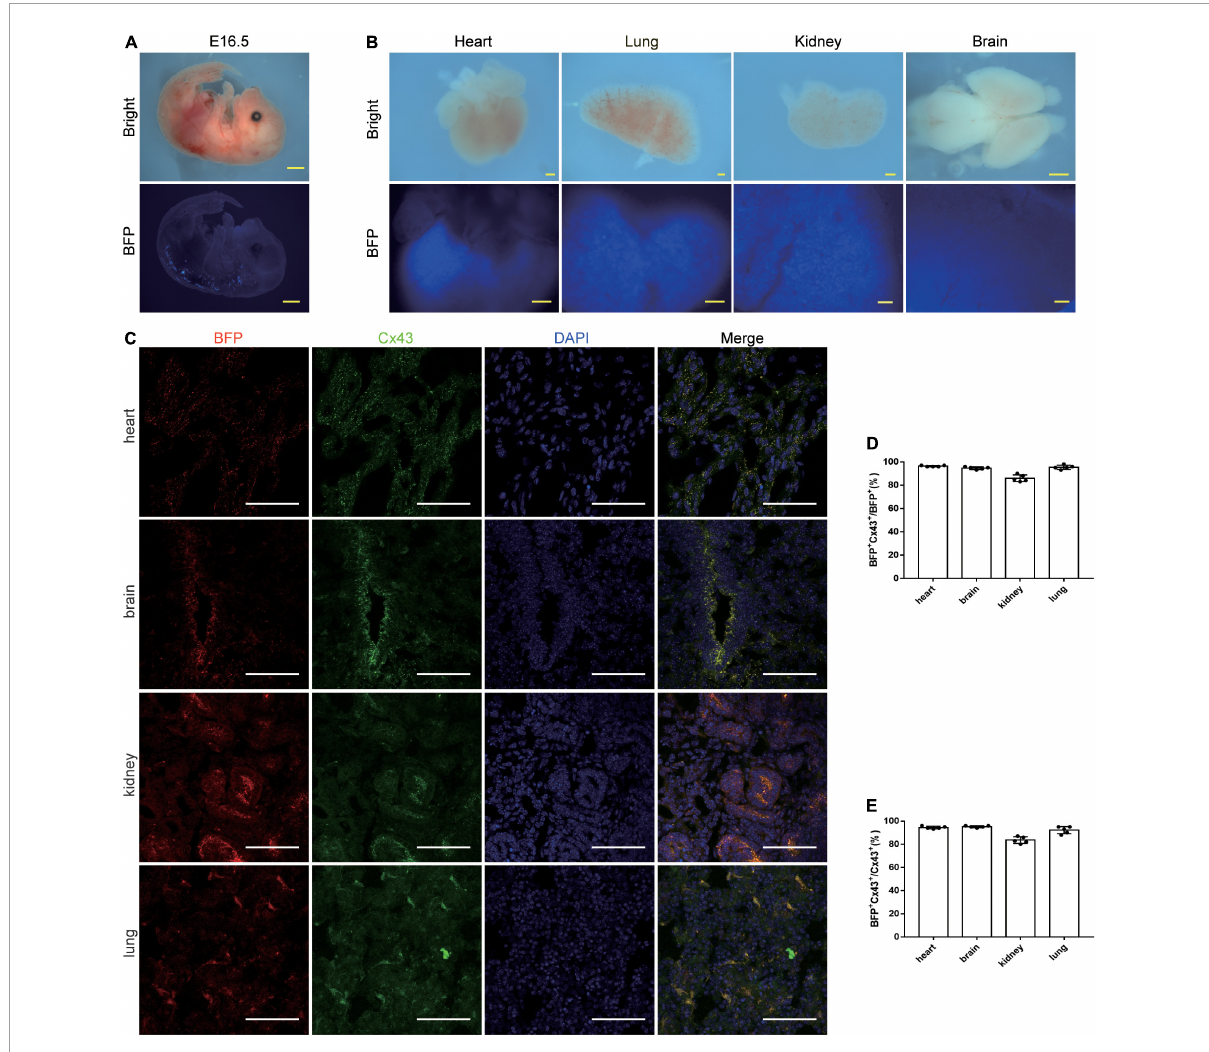
FIGURE4 Characterization of Cx43-BFP-GFP/ + reporter line of E16.5 mice. (A) Whole-mount bright field and epifluorescence images of E16.5 Cx43-BFP-GFP/ + mice; (B) whole-mount bright field and epifluorescence images of visceral organs from E16.5 Cx43-BFP-GFP/ + mice; (C) immunostaining for BFP and Cx43 on the sections of several organs. The high magnification images of organs in areas labeled with the square dotted frame, respectively; (D) quantification of the labeling efficiency by the percentage of BFP + Cx43 + in BFP + cells. Data are the mean ± SD; n = 5 images per group; (E) quantification of the labeling specificity by the percentage of BFP + Cx43 + in Cx43 + cells. Data are the mean ± SD; n = 5 images per group. Yellow scale bar = 1 mm, white scale bar = 100 µ